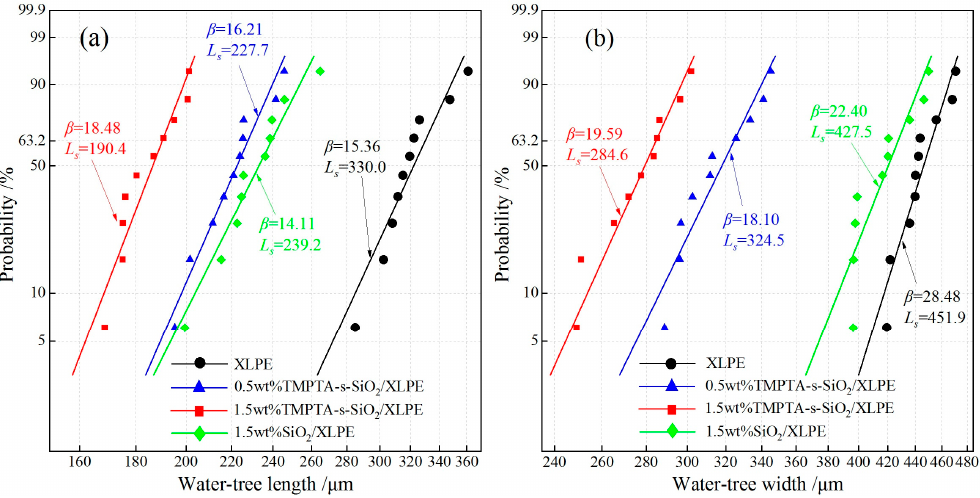
Figure 7. Water-tree characteristic ( a ) length and ( b ) width fitted in 2-parameter Weibull statistics.